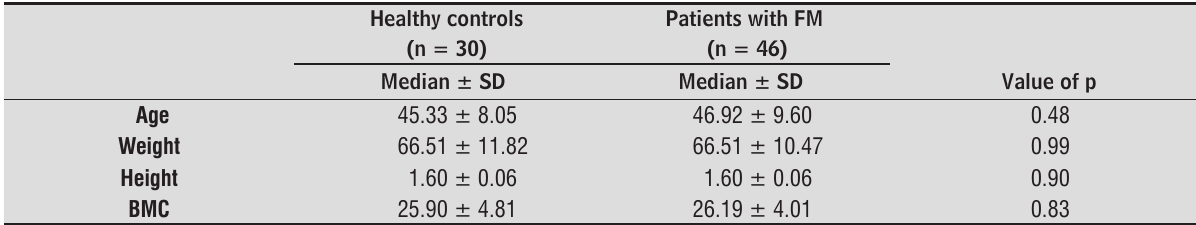
Table 1 - Characteristics of the participants in the study